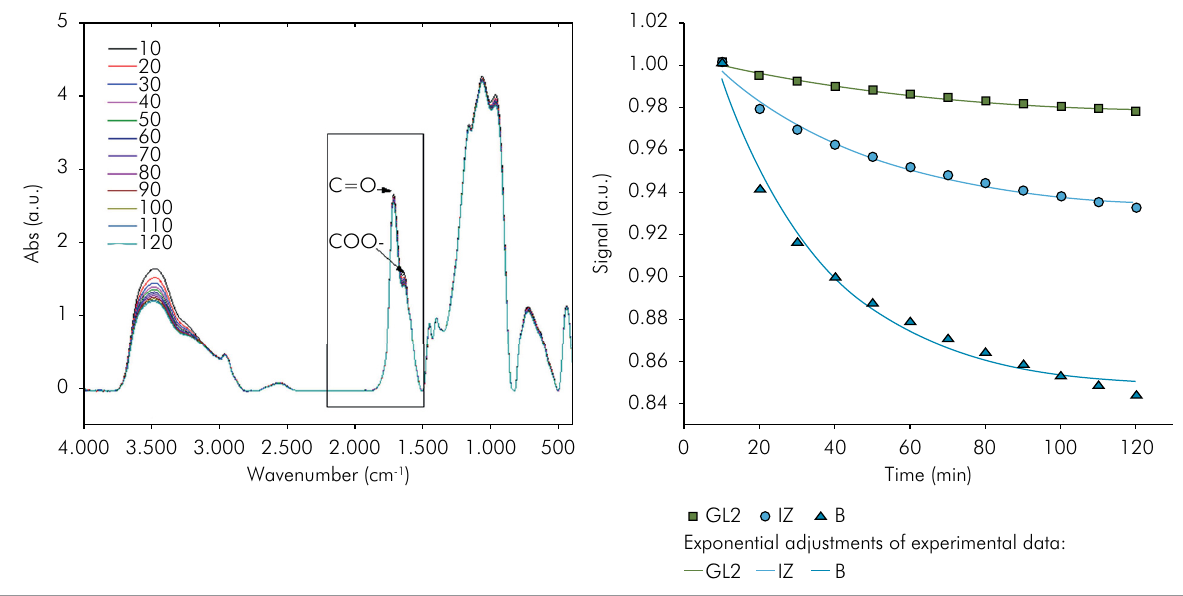
Figure 4. Fourier Transform Infrared Spectroscopy (FTIR) spectra of 3 different GICs (GL2, IZ and B) as a function of time. An exponential fitting was performed to obtain the characteristic decay time ( τ ) of